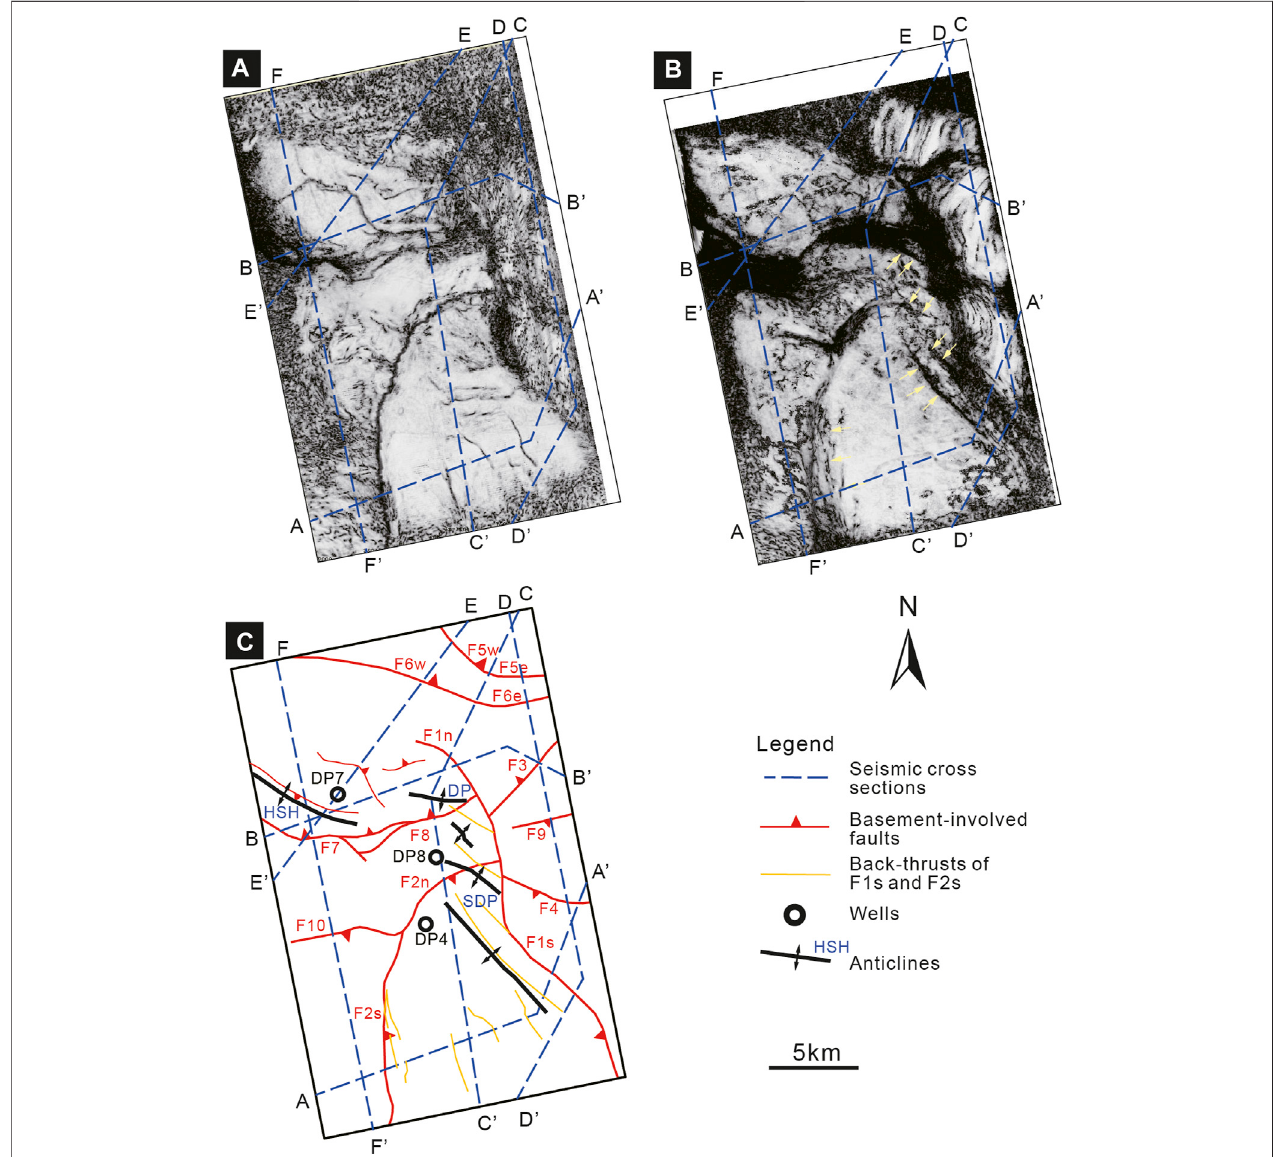
FIGURE3|(A) Along-layercoherentsliceofthebottomofLuleheformation(LLH). (B) Along-layercoherentsliceofthebottomofShangganchaigouformation(SG), yellowarrowsmarkthethin-skinnedreversefaultsthataregenerallyobliquetoF1sandF2swith < 45 ° angles. (C) FaultsystemsprojectedtothebaseofLuleheformation (LLH) in map view. HSH, Hongsanhan anticline; DP, Dongping anticline; SDP, South Dongping anticline.